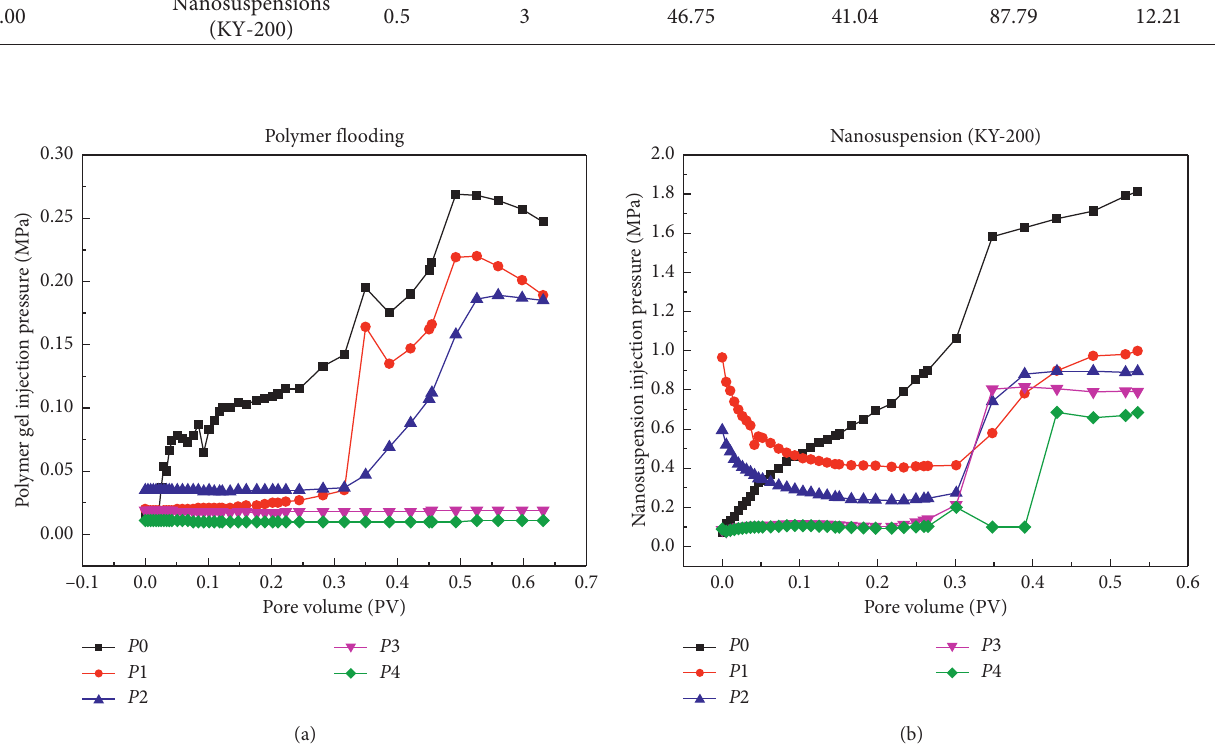
Figure 4: Polymer gel and nanosuspension injection pressure vs.